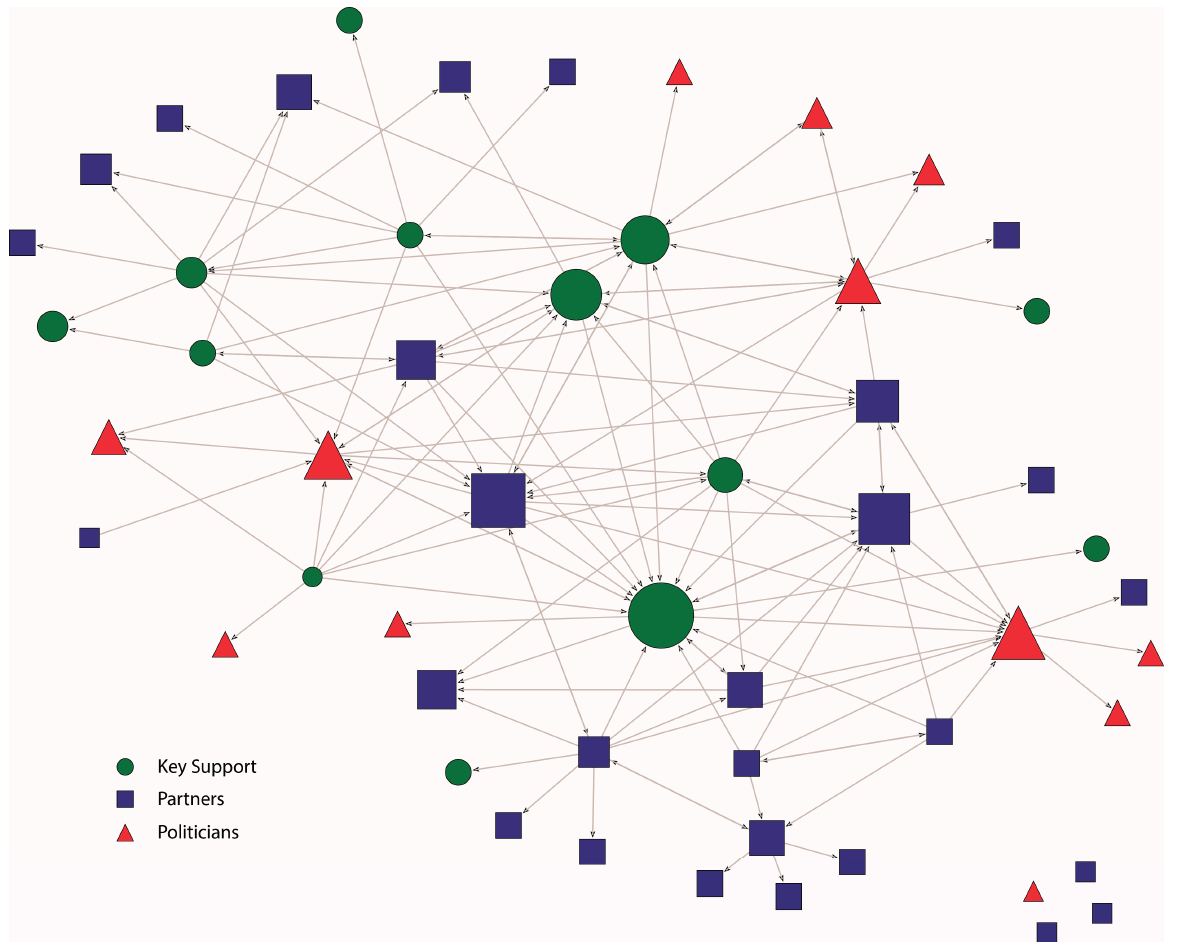
Figure 1. Kansas City Smokefree Policy Importance network. Nodes are sized according to the number of importance nominations. Links show direction of importance